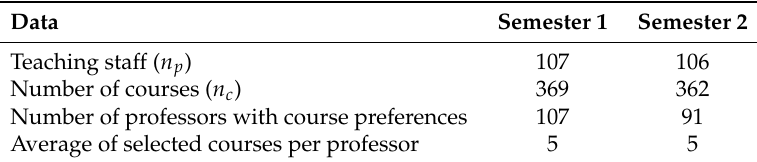
Table 1. Data of the two test semesters for the ACA